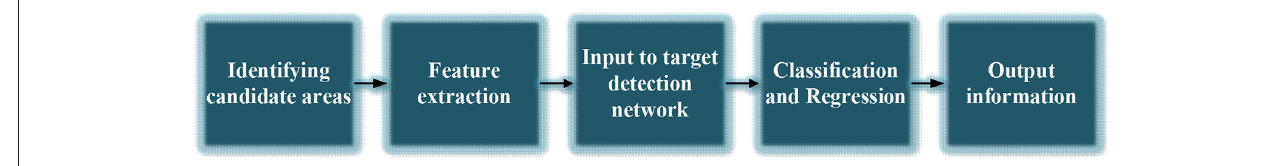
FIGURE 2 | Detection flow of the target identification algorithm (TIA).